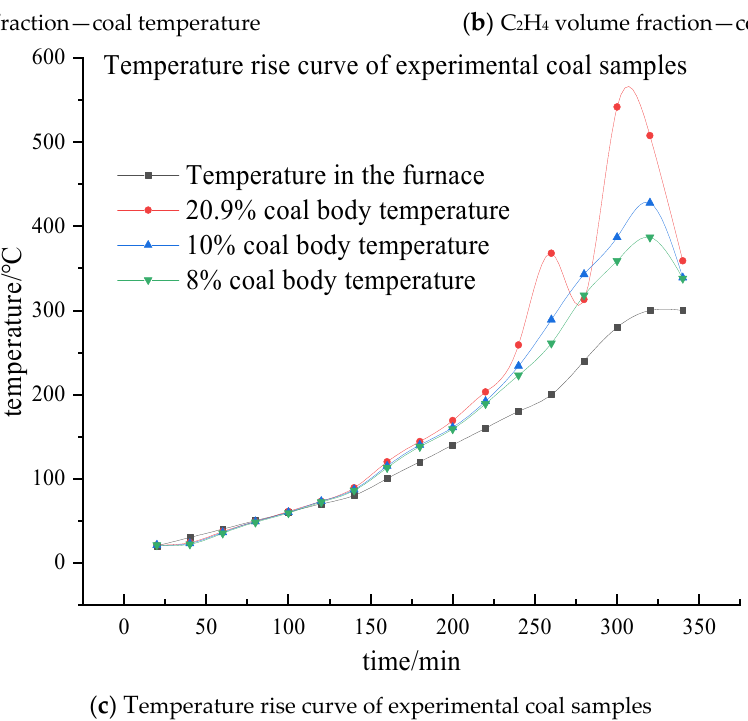
Figure 3. The law of coal temperature, CO, and C 2 H 4 concentration changing with time.